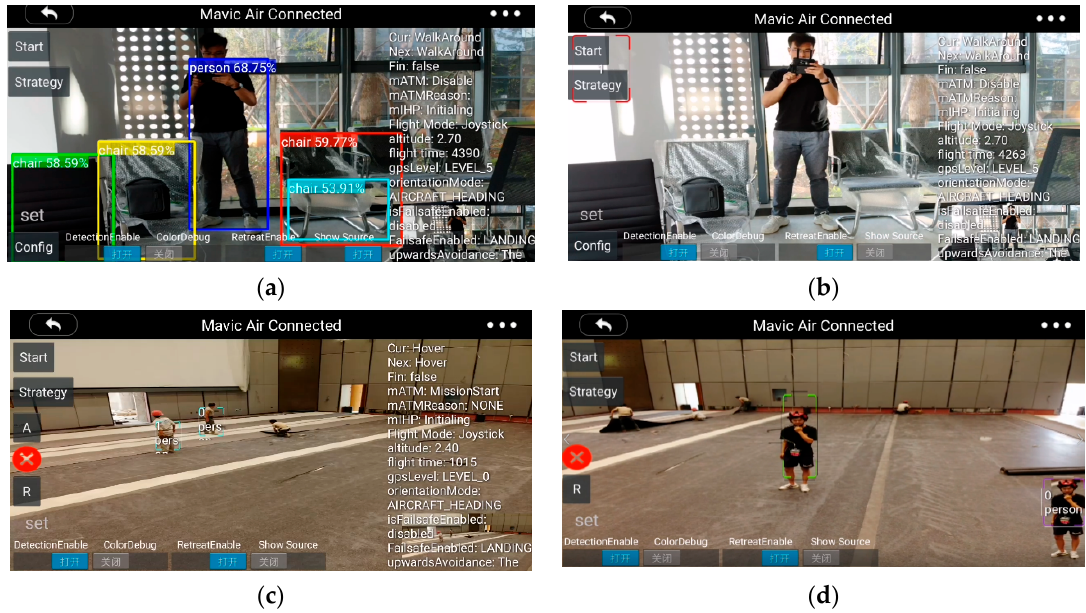
Figure 17. Screenshot of the smartphone: ( a ) object detection algorithm enabled; ( b ) object detection disabled; ( c ) detect the man with a red helmet and mark him with a purple rectangle; ( d ) detect and track the man with a red helmet.